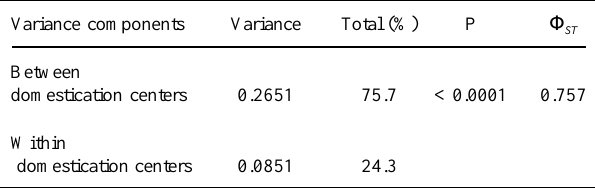
Table II - Analysis of molecular variance of 27 common bean cultivars based on RAPD markers. Variance